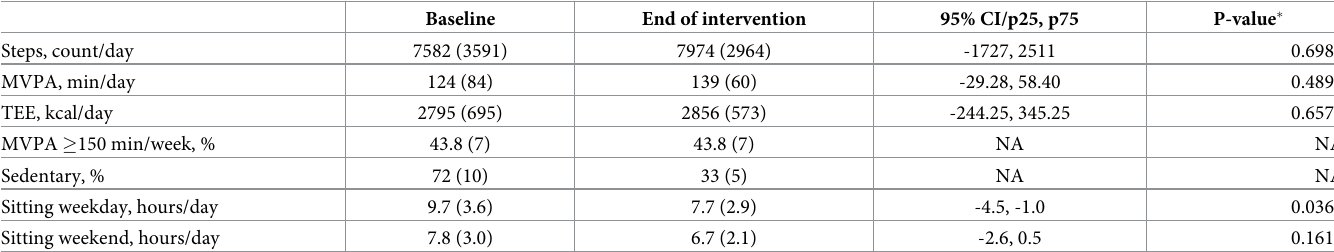
Table 3. Change in physical activity from baseline to end-of-intervention. The RESTART pilot study 2017–18. Baseline End of intervention 95% CI/p25, p75 P-value �